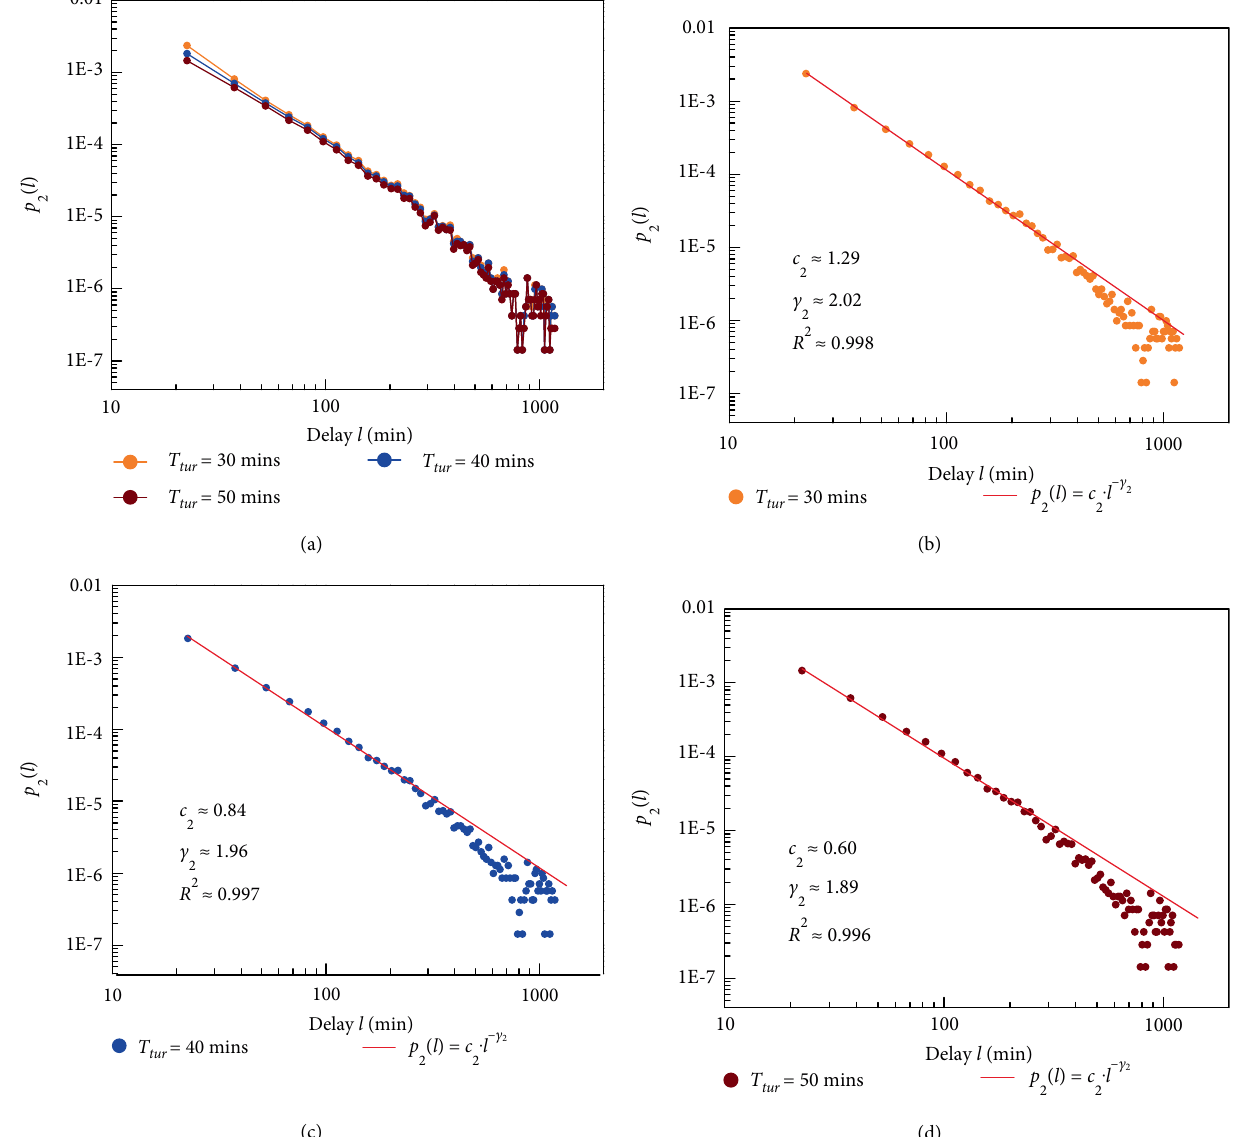
Figure 2: (a) Log–log plots of the departure delay (remove the delayed flights causing by PF) distribution 𝑝 respectively. (b)–(d) are the curve fitting of the departure delay distribution with 𝑇 the goodness of fit is shown in